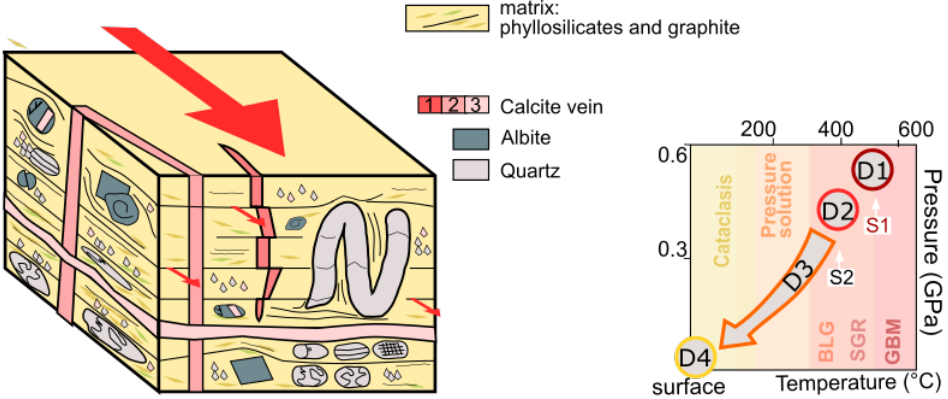
Figure 9. Left; a 3-D block cartoon to show the deformation features. Grey — remnants of folded quartz veins (D1), pink — calcite veining (D4), black lines — D2 foliation and D3 pressure solution planes, green minerals — albite grains. Right; a P-T diagram to summarize the different stages of the fault gouge sample during exhumation (supported by Rings & Merle 1992 [39]; Grasemann and Mancktelow 1993 [33]; Campani et al. 2010 [36]; Bousquet et al., 2002 [74]; Montemagni and Zanchetta [41]; Cawood and Platt 2000 [75]). BLG — grain bulging, SGR — sub-grain rotation, and GBM — grain boundary migration.